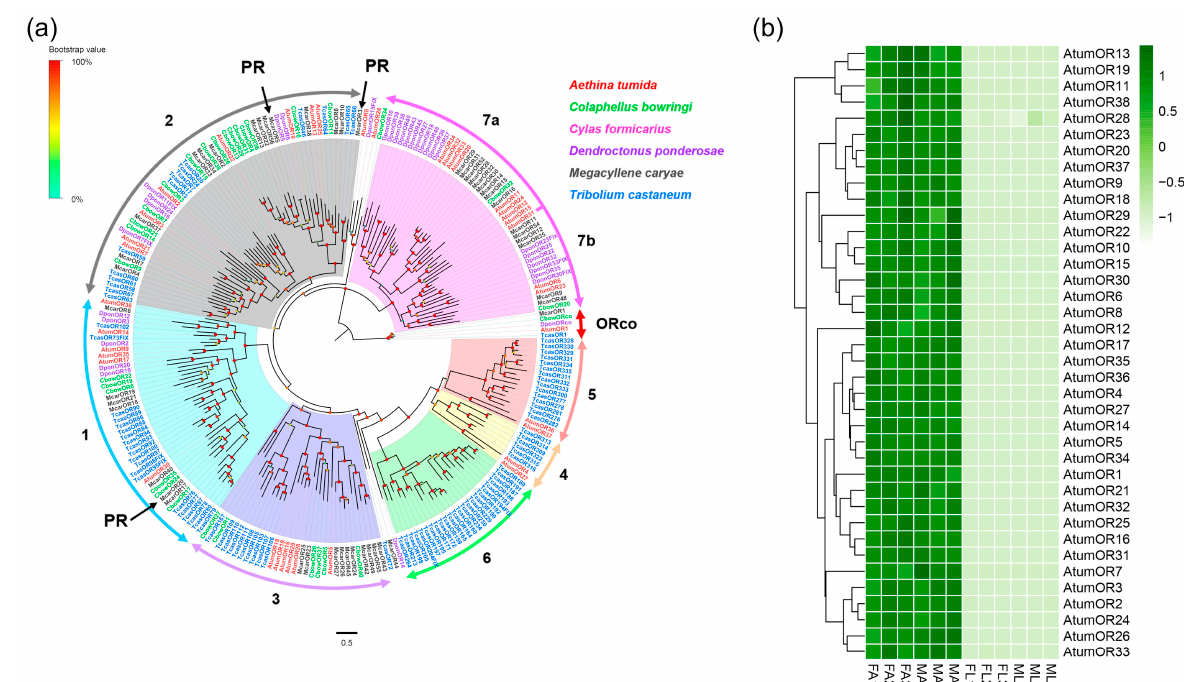
Figure 1. Analyses of putative odorant receptors (ORs) in A. tumida . ( a ) Maximum-likelihood tree of putative ORs. The tree was rooted with the conserved Orco orthologues. Circles at the branch nodes represent bootstrap values based on 1000 replicates. Scale bar represents the 0.5 amino acid substitutions per site. The different subfamilies are highlighted as blue, gray, purple, yellow, coral, green and pink, respectively. Orco is highlighted as red. ( b ) Heatmap of ORs based on antennae and forelegs transcriptome data in A. tumida . FA, female antennae; MA, male antennae; ML, male forelegs; FL, female forelegs. The transcript abundance was measured by FPKM-values. All 38 ORs were mainly expressed in the FA and MA. Three independent biological replicates were conducted for each sample (such as FA1, FA2, and FA3).